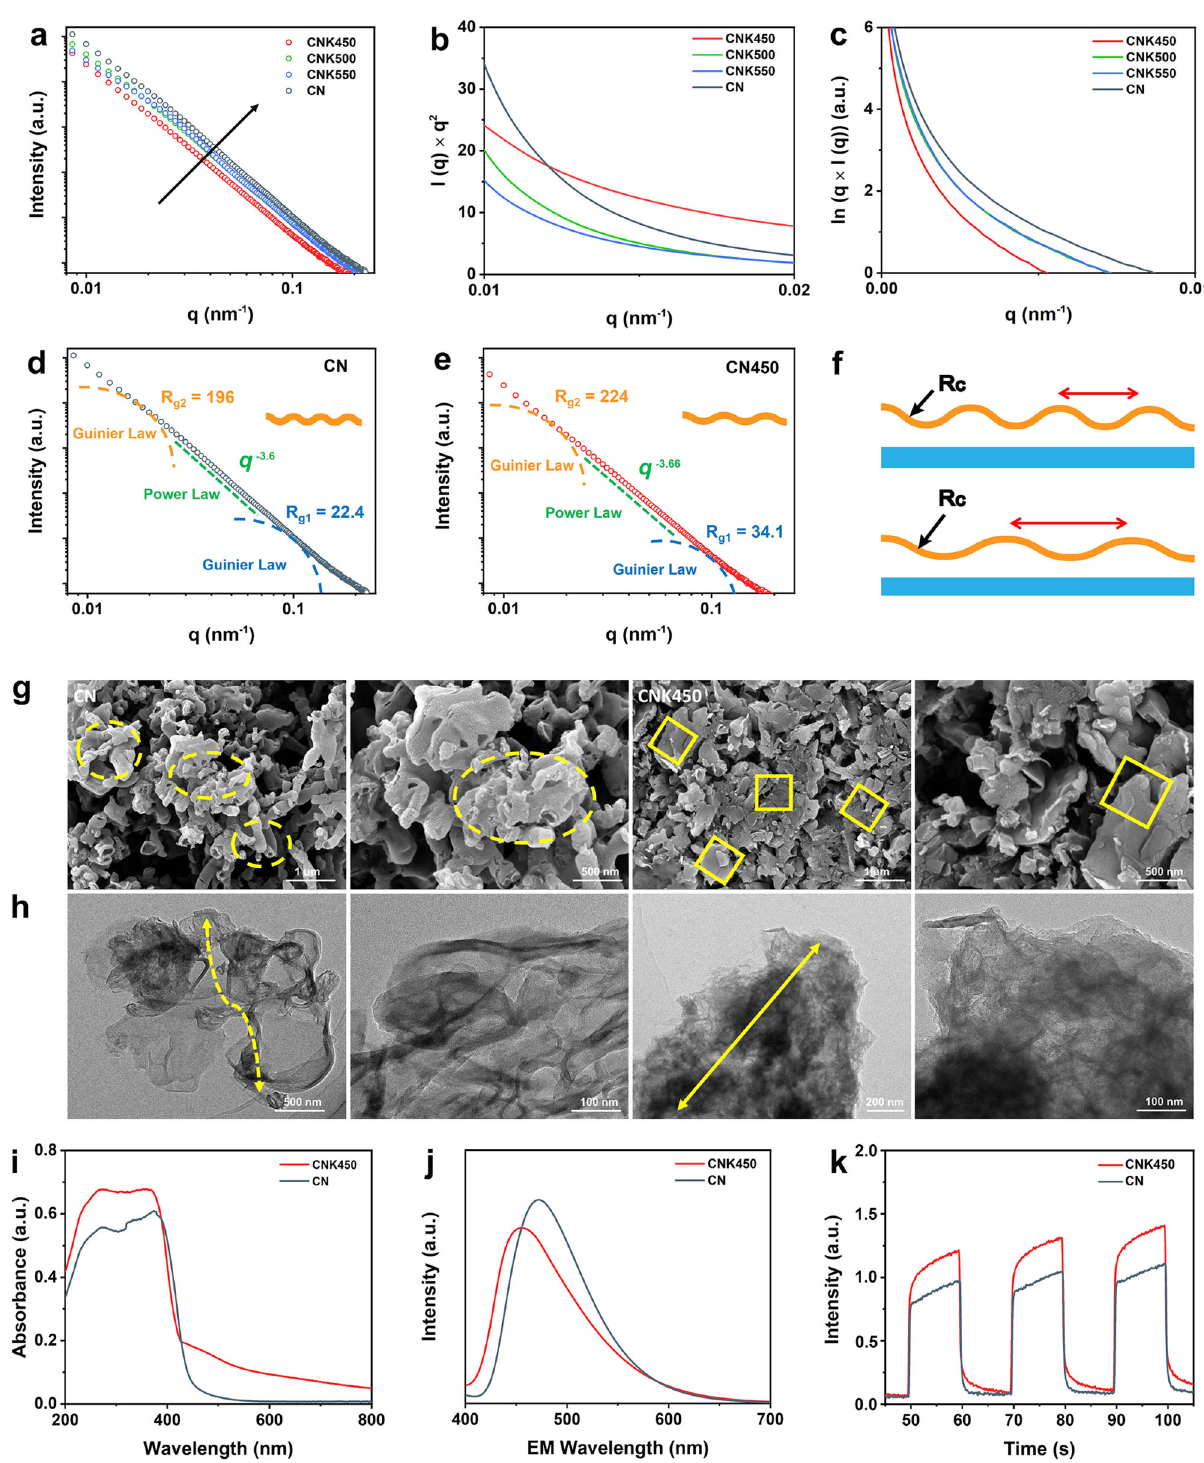
Fig. 2 Structural of g-C 3 N 4 samples and their photoelectrochemical behaviors. a SAXS curves. b Kratky plots of the SAXS scattering pro fi les. c Cross- sectional Guinier plots of the SAXS pro fi les. Fitted SAXS patterns along with schematic representations of the fractal network of CN ( d ) and CNK450 ( e ). f Schematic illustration of g-C 3 N 4 morphology. g SEM images of CN and CN450 and h TEM images of CN and CN450. i UV – vis absorption spectra of CN and CN450. j Photoluminescence (PL) spectra of CN and CNK. k Photocurrent curves over time of CN and CNK. The yellow line represents the morphology of CN and